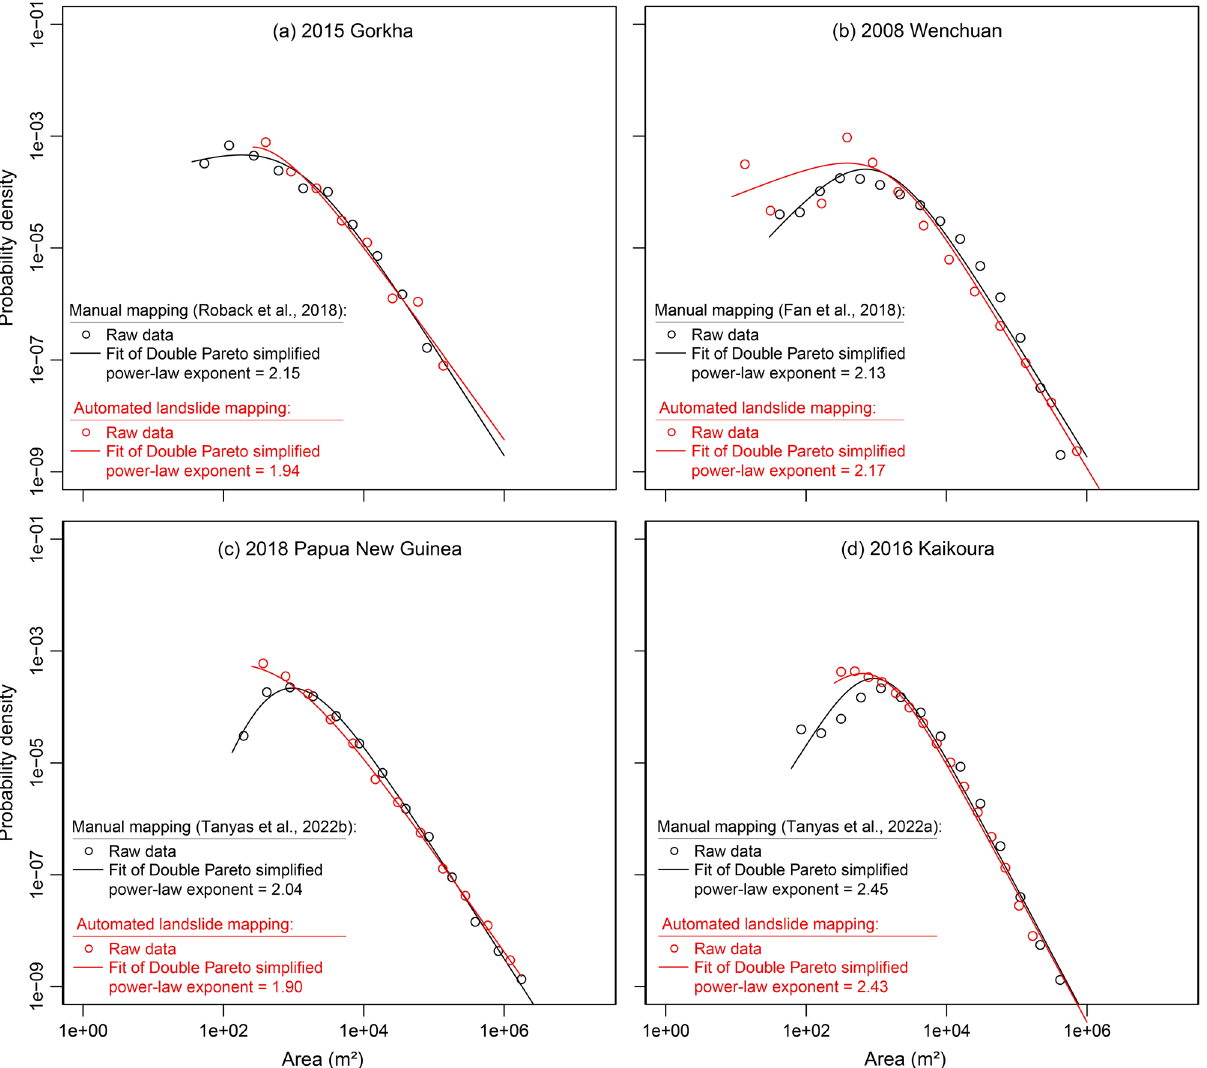
Figure 9. Frequency Area Distribution of the mapped inventories from the literature versus the prediction inventories for the four study areas. Note that the amount of data in 2015, Gorkha might be insufficient to delineate clear patterns and identify a roll-over